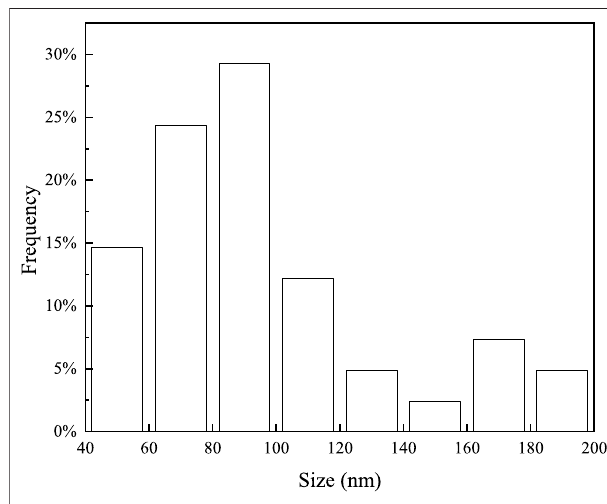
FIGURE 7 | Size distribution of bubble-loop complexes in irradiated Fe- 9Cr alloy.